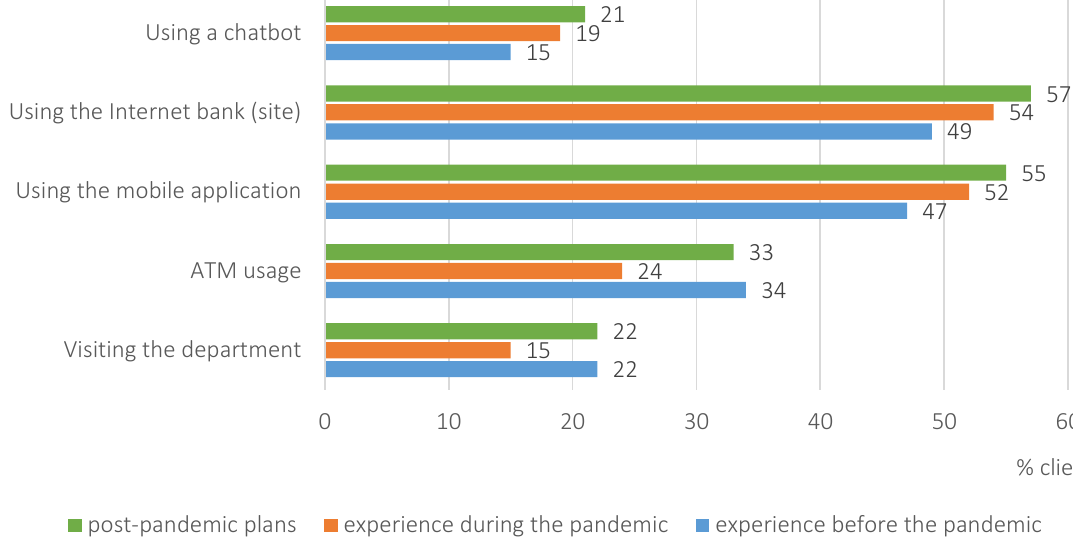
Figure 1. Share of bank customers using certain banking